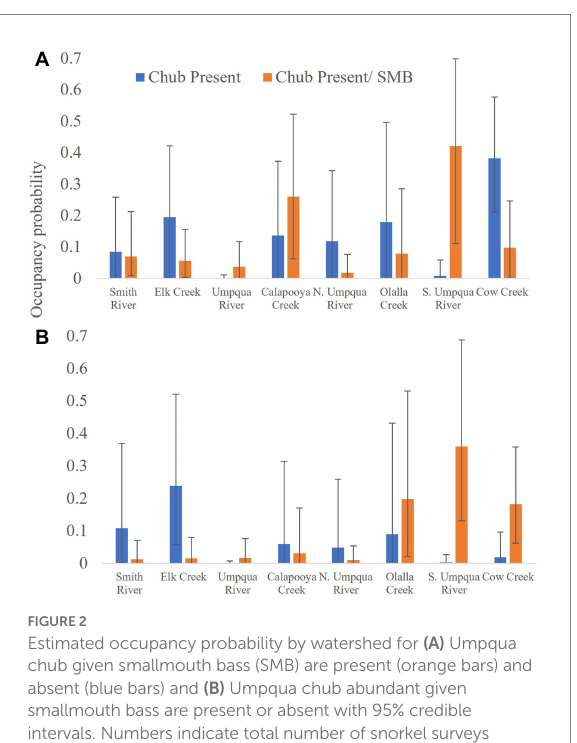
FIGURE 2 Estimated occupancy probability by watershed for (A) Umpqua chub given smallmouth bass (SMB) are present (orange bars) and absent (blue bars) and (B) Umpqua chub abundant given smallmouth bass are present or absent with 95% credible intervals. Numbers indicate total number of snorkel surveys conducted per watershed in the Umpqua Basin, Oregon, United States, 2006–2021. FIGURE 3